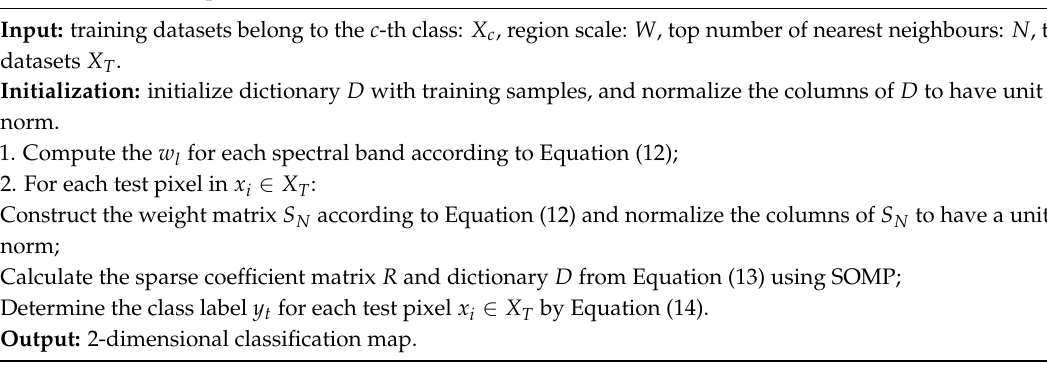
Algorithm 1. The implementation of